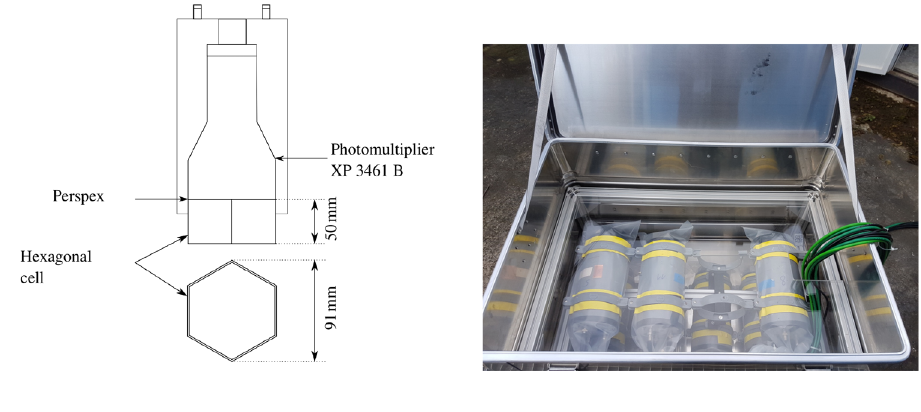
Fig. 5 Left: schematic drawing of the neutron detectors used in the neutron set-up (see text). Right: detector array box